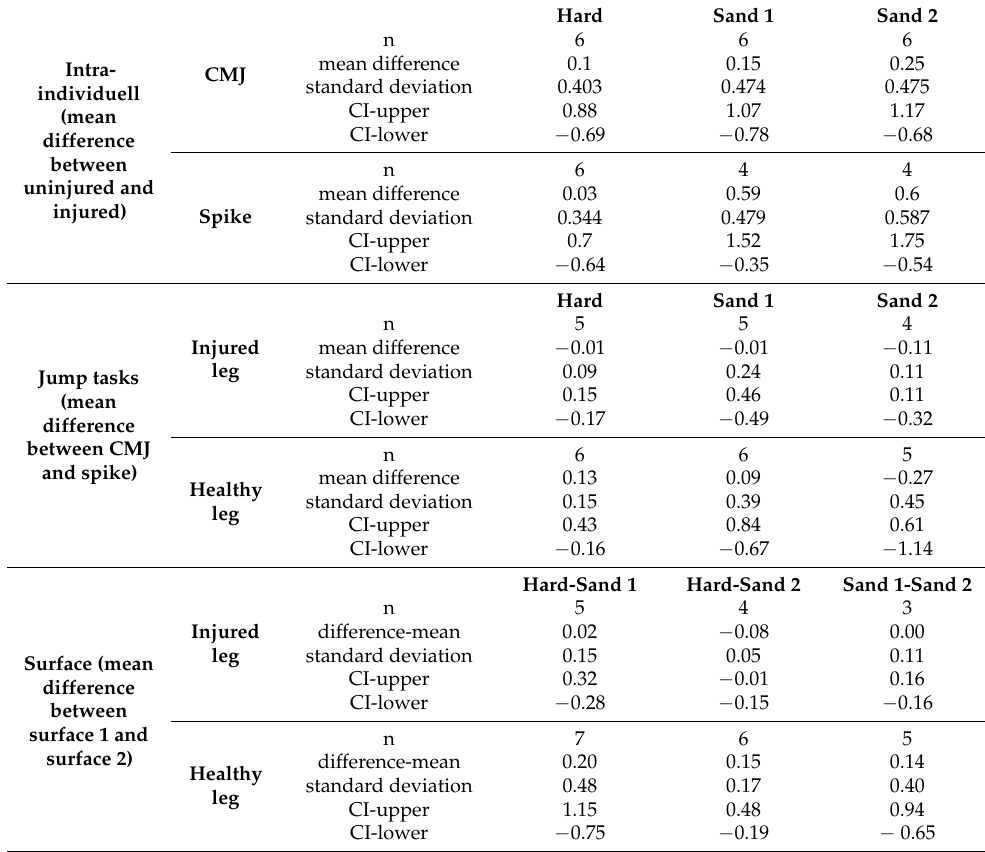
Table 4. Differences in means, standard deviations, and upper and lower limits of 95% confidence intervals of Bland–Altman analysis for intra-individual differences, jump tasks, and surfaces. The upper table part resents the difference in VM/VL ratios between the uninjured and injured legs of unilaterally injured athletes. This comparison was made for the CMJ and spike jump. VM/VL ratio of the uninjured leg, especially in the spike jump, was higher than in the injured leg. The middle part presents the difference in VM/VL ratios between the counter-movement jump (CMJ) and spike jump for the leading leg and the lower part between surfaces. In both cases, the data were split into the leading leg of injured and healthy groups. Differences in means, standard deviations, and confidence intervals were much lower for the leading leg in the injured group compared with those of the healthy group for jump tasks and